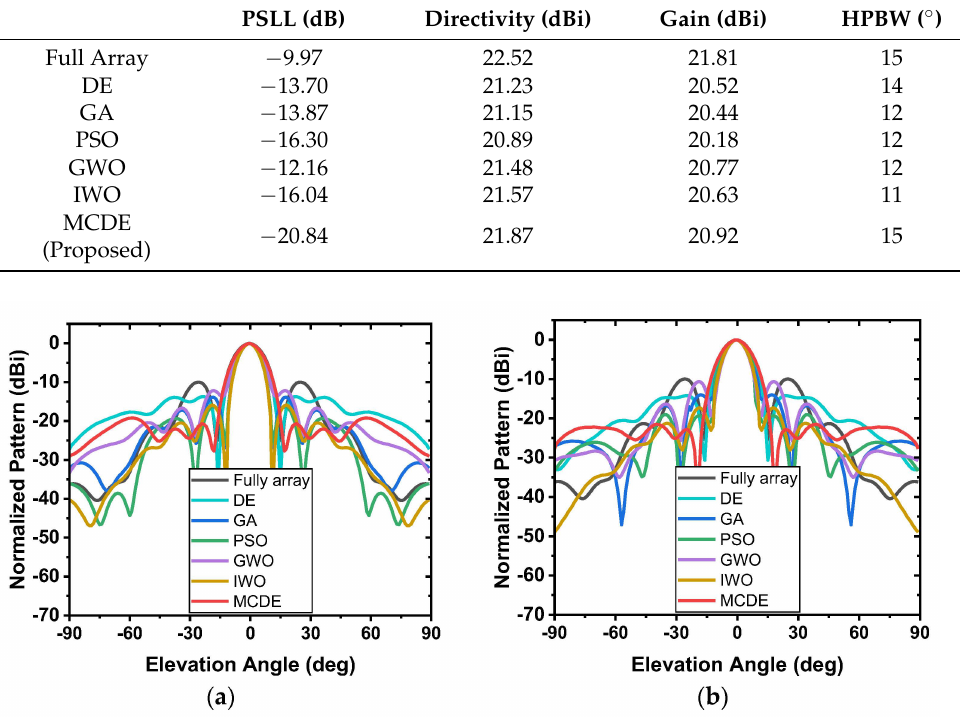
Figure 8. Radiation patterns of the full array, sparse array synthesized by MCDE and DE algorithm. ( a ) ϕ = 0 ◦ plane. ( b ) ϕ = 90 ◦ plane.